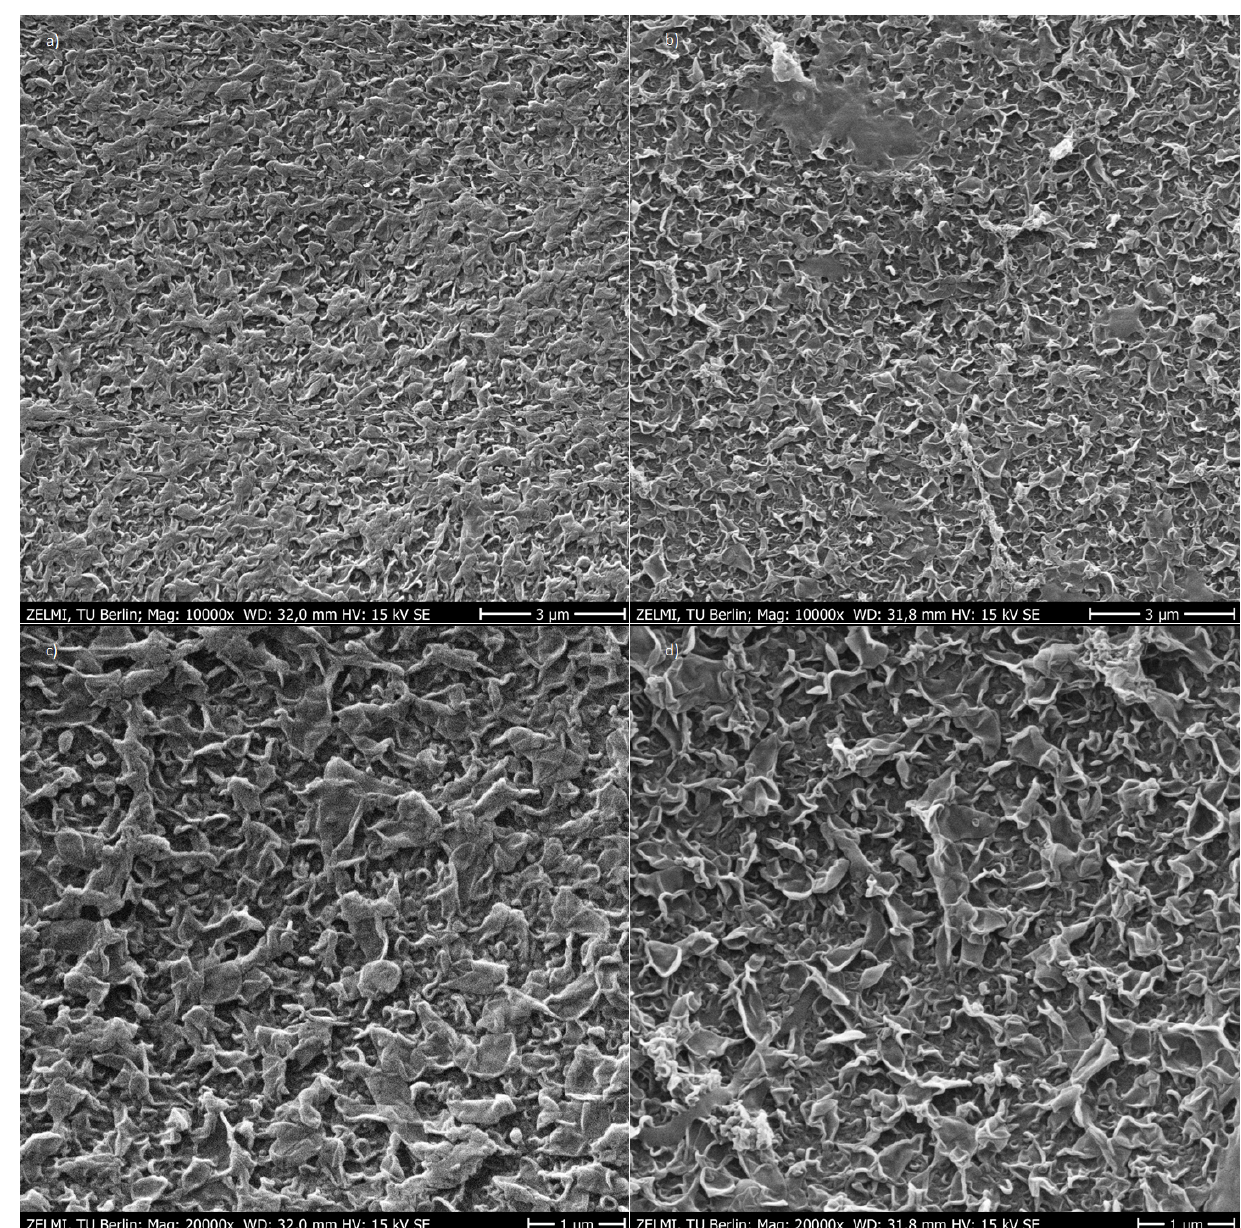
Figure 10. ( a ) BW30 flat sheet membrane unused 10,000 × magnification, ( b ) BW30 flat sheet mem- brane used 10,000 × magnification, ( c ) BW30 flat sheet membrane unused 20,000 × magnification, ( d ) BW30 flat sheet membrane used 20,000 ×